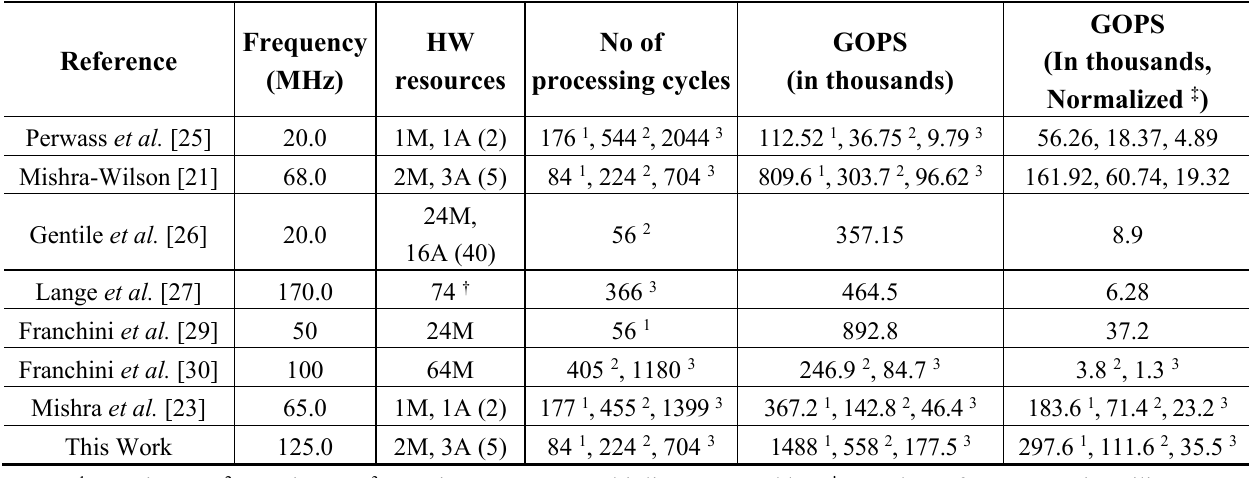
Table 2. GA performance figures and comparison with previously published